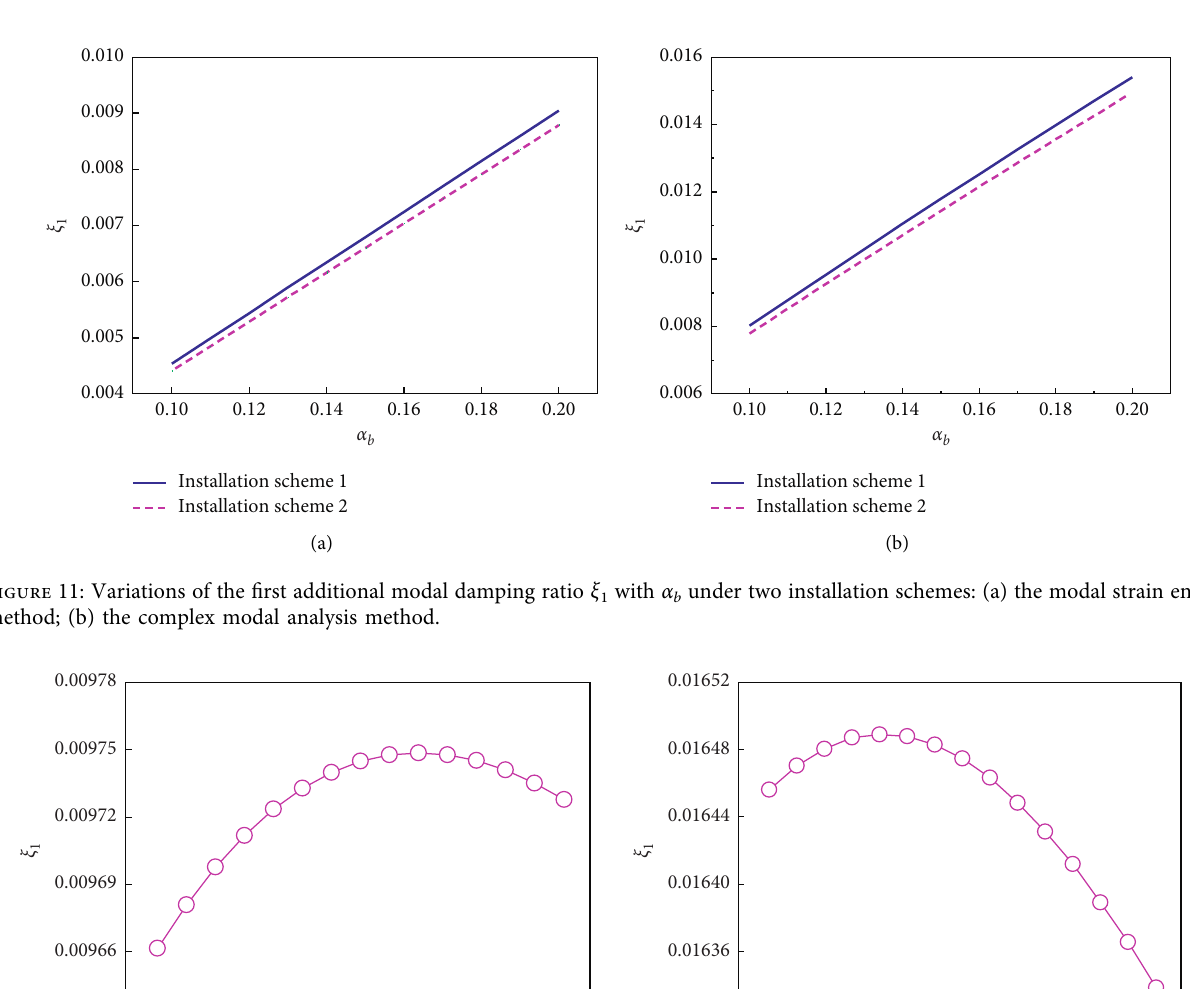
1 with λ : (a) the modal strain energy method; (b) the complex modal